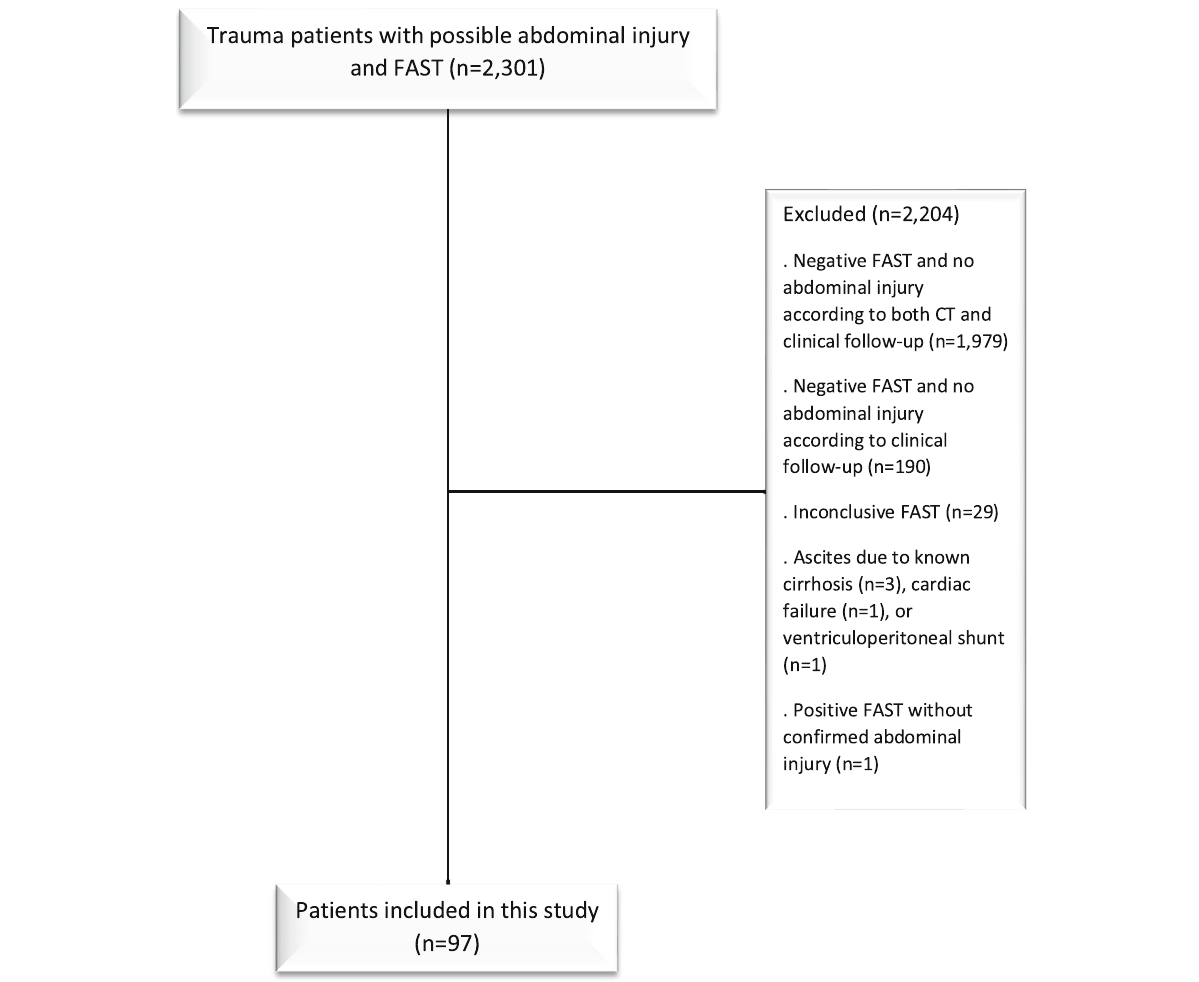
Fig. 1 Flowchart of patient inclusion. Out of all 2301 consecutive patients who underwent FAST within a 26-month period at our institution, 314 underwent abdominal CT. Of 97 patients who were included in this study, 96 underwent abdominal CT, while 1 was not sufficiently hemodynamically stable to undergo abdominal CT, and this patient underwent immediate subsequent surgery. All other 96 patients with confirmed abdominal injury who were included in this study underwent abdominal CT after FAST. Also note that when considering the entire group of patients who undergoes FAST, patients with a negative FAST will have a better outcome than those with a positive FAST, regardless of whether they actually have abdominal injury or not. However, before doing this study, it was unclear if FAST has any value in predicting outcome in patients who actually do have abdominal injury. This was the reason of excluding patients without confirmed abdominal